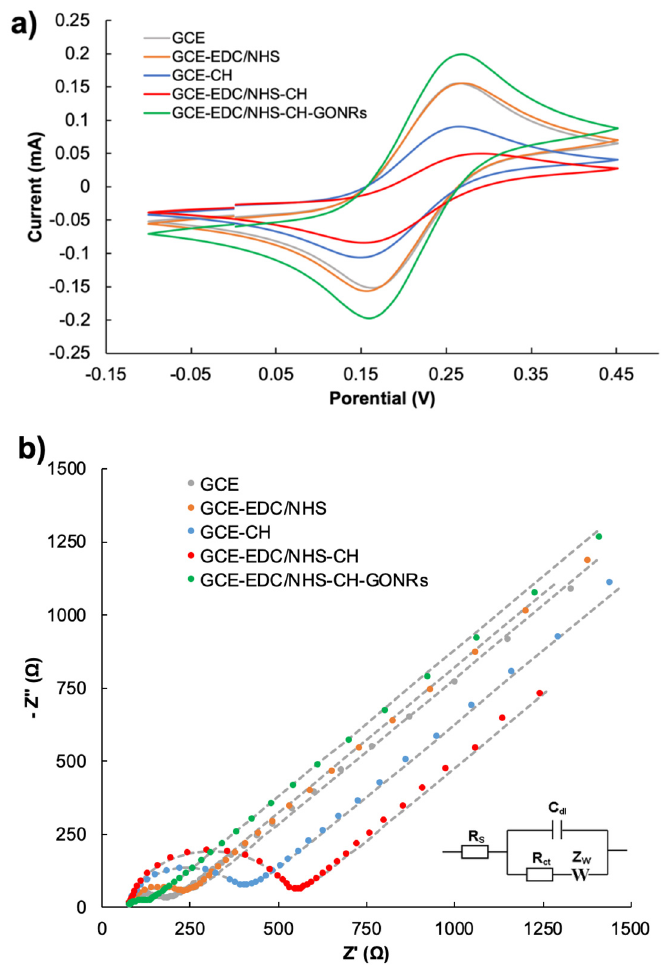
Figure 3. Cyclic voltammograms ( a ) and the Nyquist plots ( b ) of GCEs after various modifications. GCE (grey), GCE / CH (orange) and GCE / GONRs-CH (green). EIS measurements were performed in 10 mM [Fe(CN) 6 ] 3 − / 4 − with 0.10 M KCl over the frequency range from 0.1 Hz to 100 kHz with a potential of 0.28 V vs. Ag / AgCl on a 10 mV potential amplitude. R ct values were obtained by the fitting of the Nyquist plot with the modified Randle equivalent circuit (shown in b, inset).